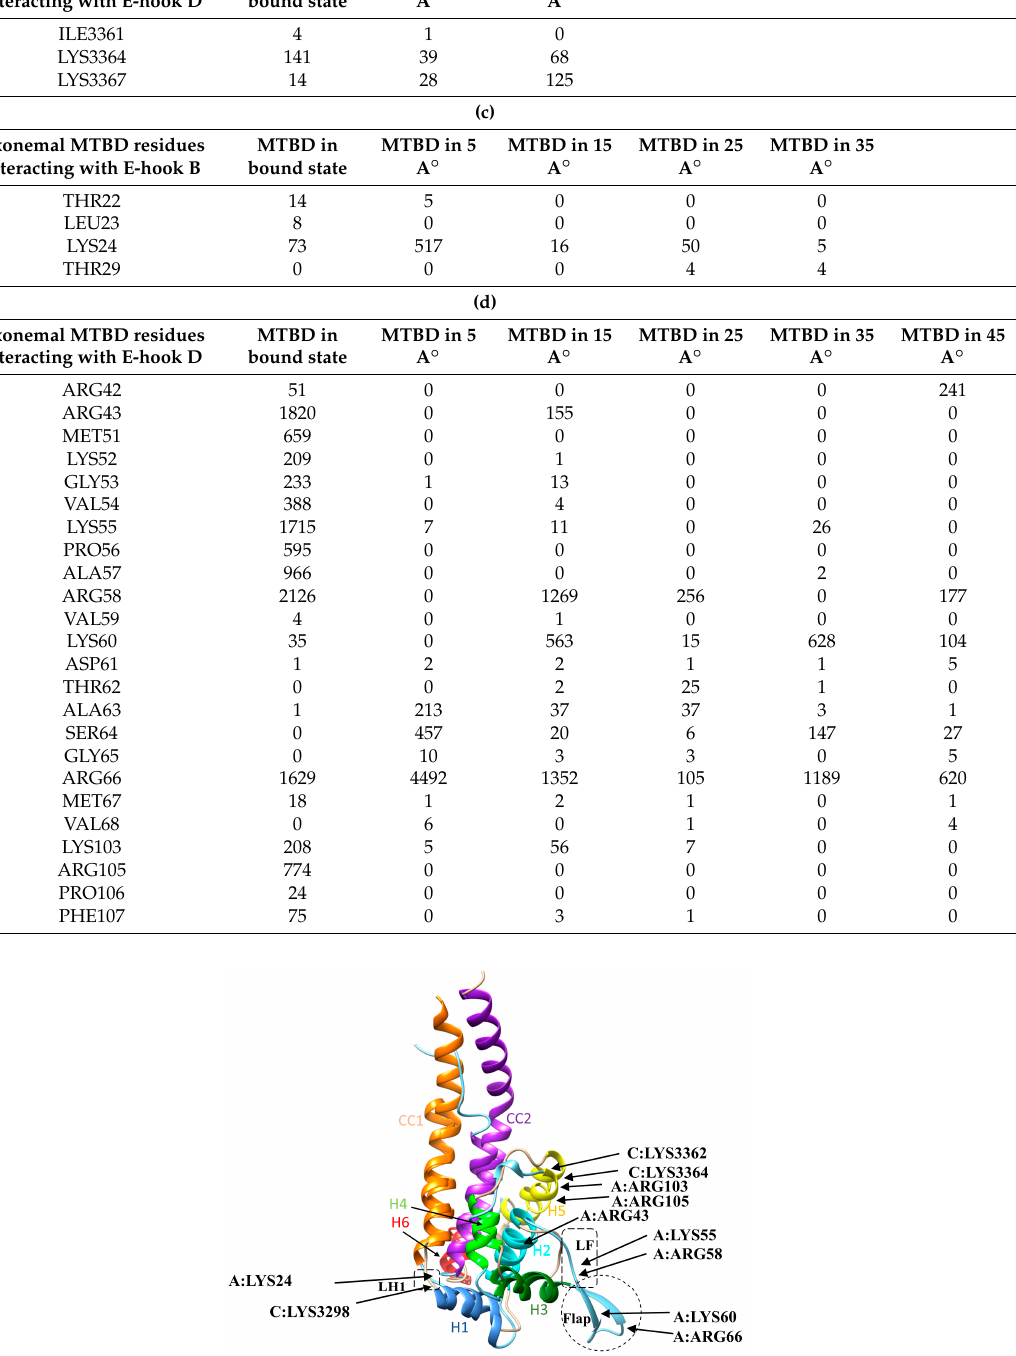
Figure 6. Superimposition of axonemal and cytoplasmic MTBDs along with the residues contributing largely in the contacts with E-hooks. C and A stand for cytoplasmic and axonemal, respectively. (The dotted circle and square indicate the flap region and loop next to the flap region (LF) in axonemal MTBD, respectively).